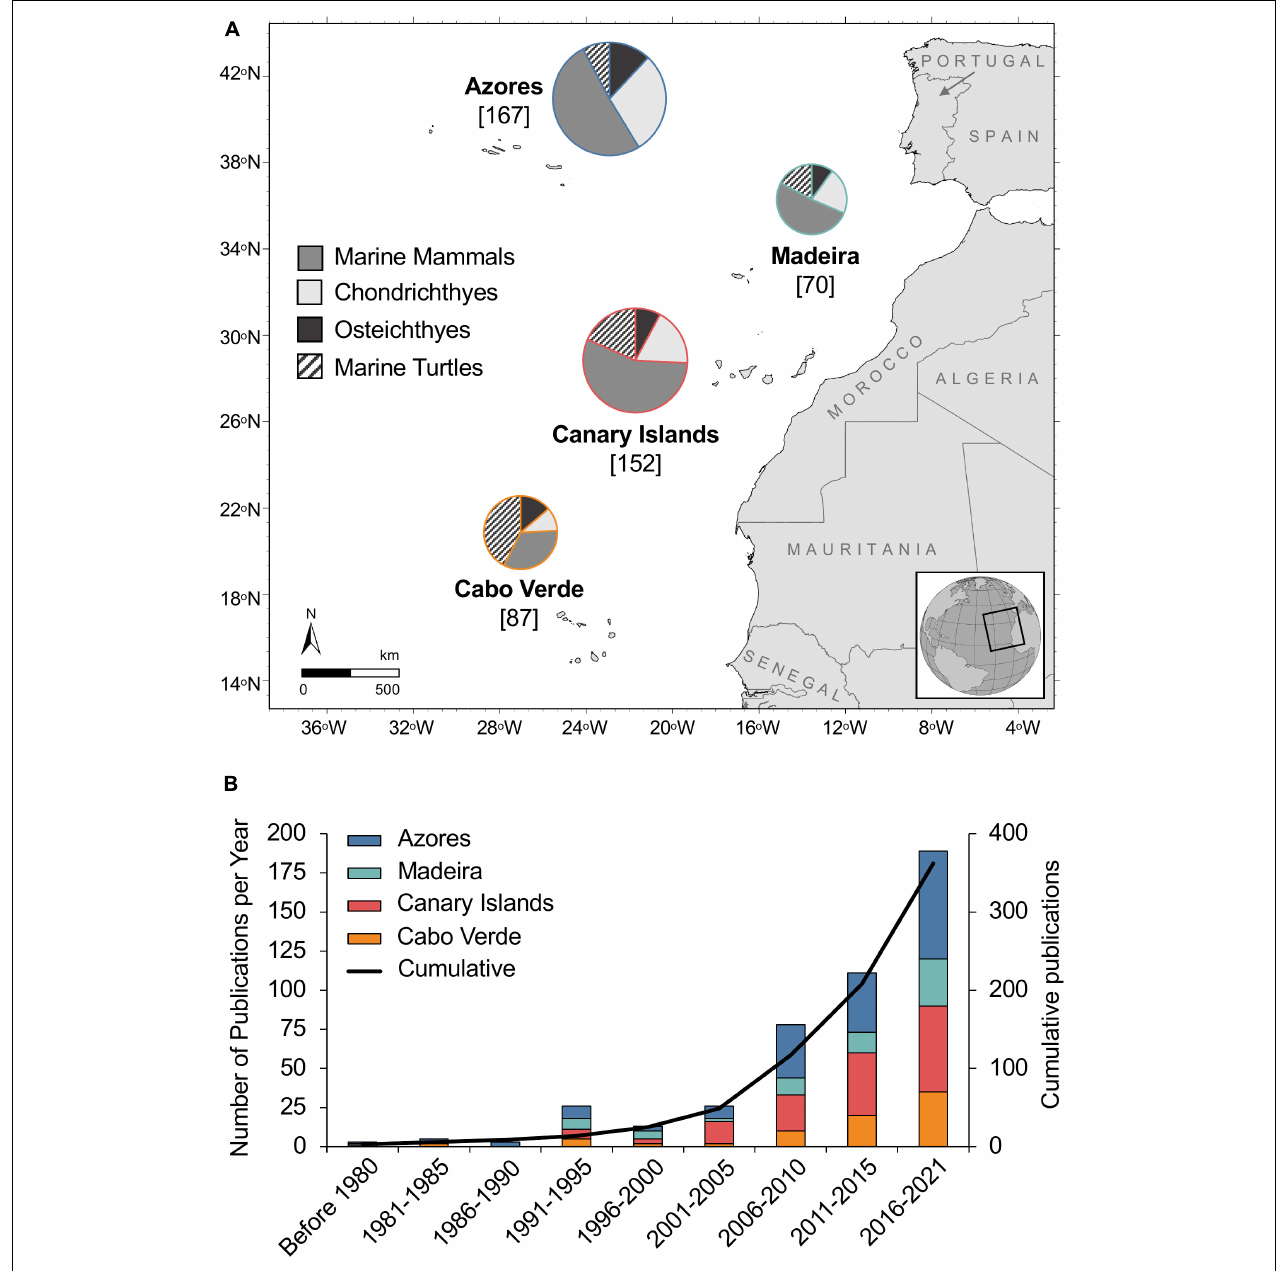
FIGURE 2 | Quantitative representation of reviewed publications by Macaronesian archipelago in relation to (A) composition of focal taxa (size of chart scaled to relative number of publications) and (B) publication trends over